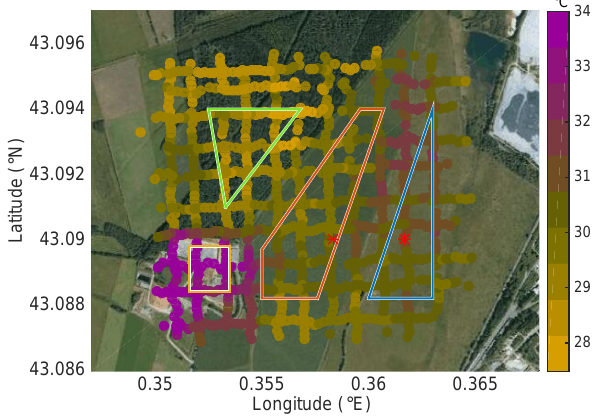
Figure 9. Surface temperature from Site 1 on 19 June 2011 at 19:41UTC measured using the downward-looking SUMO IR sen- sor. Data are only shown for the straight flight legs, where the IR sensor is assumed to look vertically down. The red square marks the location of the “small-scale heterogeneity site”.